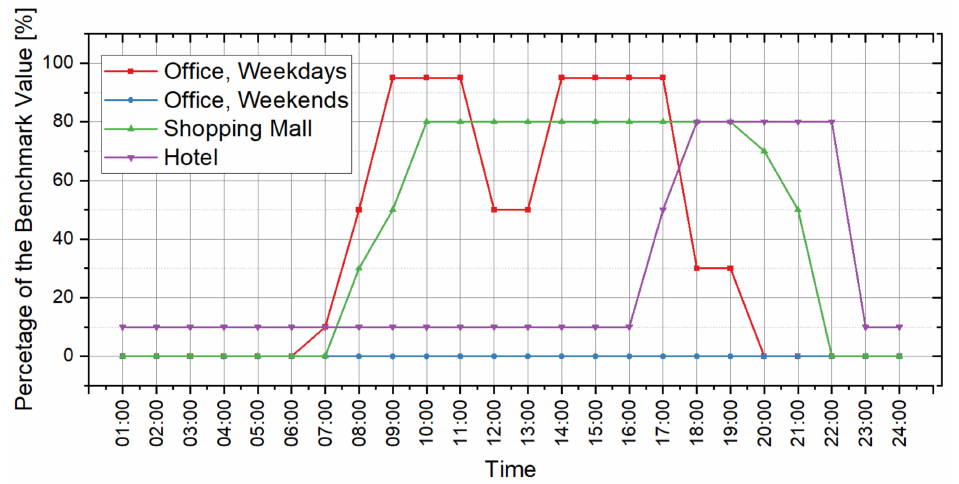
Figure 6. Schedule of plug equipment power density.